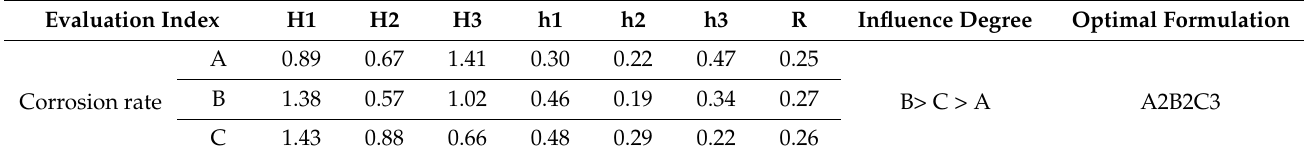
Table 4. Range analysis of orthogonal test with corrosion rate as evaluation